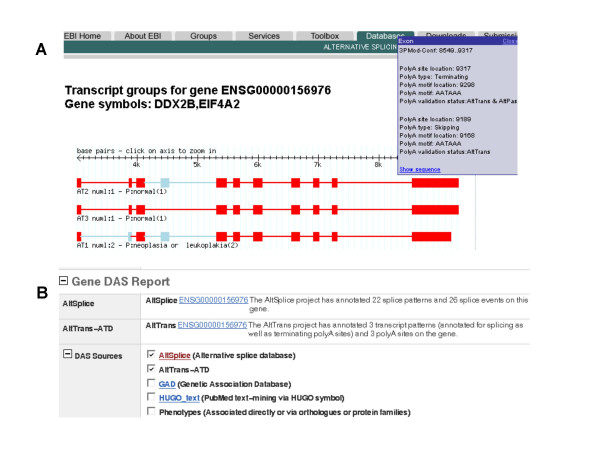
Inset A: Example of transcript pattern view. Exons are indicated by boxes and introns by lines. Exons/introns that are variants are indicated in blue colour. Browsing the cursor over various elements of a pattern displays pop-up's giving detailed information on the elements. The displayed pop-up in this example shows information on the polyA sites that maps to the alternate transcript pattern AT2; of these two polyA sites, the first one (located at gene position 9317) terminates the transcript pattern while the second one (located at gene position 9189) is skipped and is not used as a terminating polyA in the formation of this pattern. Inset B: Example snapshot of a portion of Ensembl gene display page to illustrate the integration of the AltTrans data in Ensembl genome annotation project.